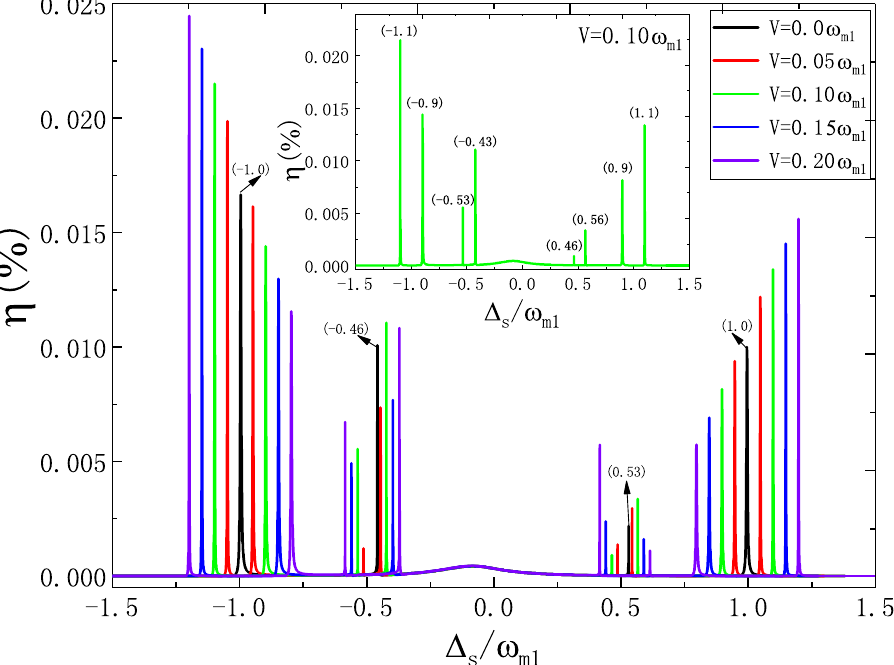
Figure 4. The efficiency η of SSG versus ∆ s / ω m 1 for several different coupling strengths V with the parameters P c = 1.5 µ W and ω m 1 = ω m 2 under the condition of ∆ c = 0, and the inset gives the condition of V = 0.1 ω m 1